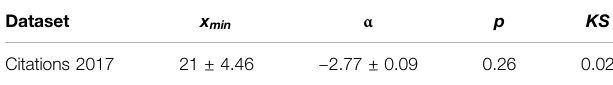
TABLE 3 | Results of fi tting the power law to the citation distribution.